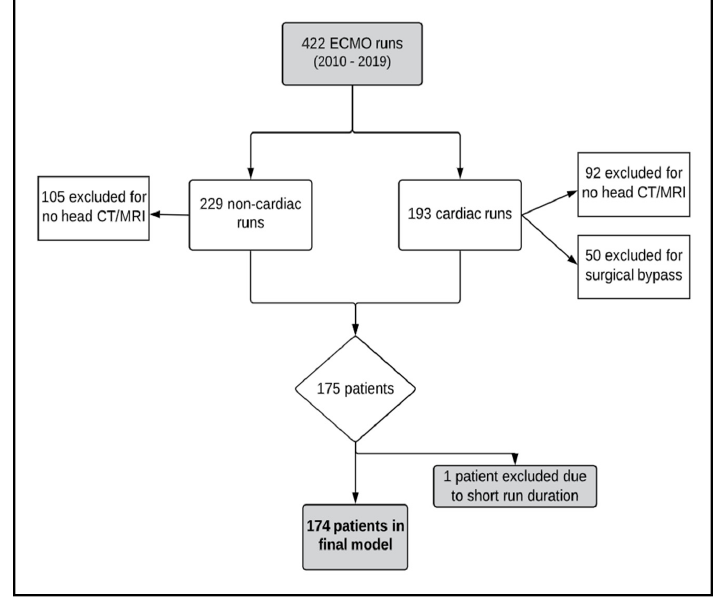
Figure 1. Schematic outlining patients identified, excluded from, and included in the study.